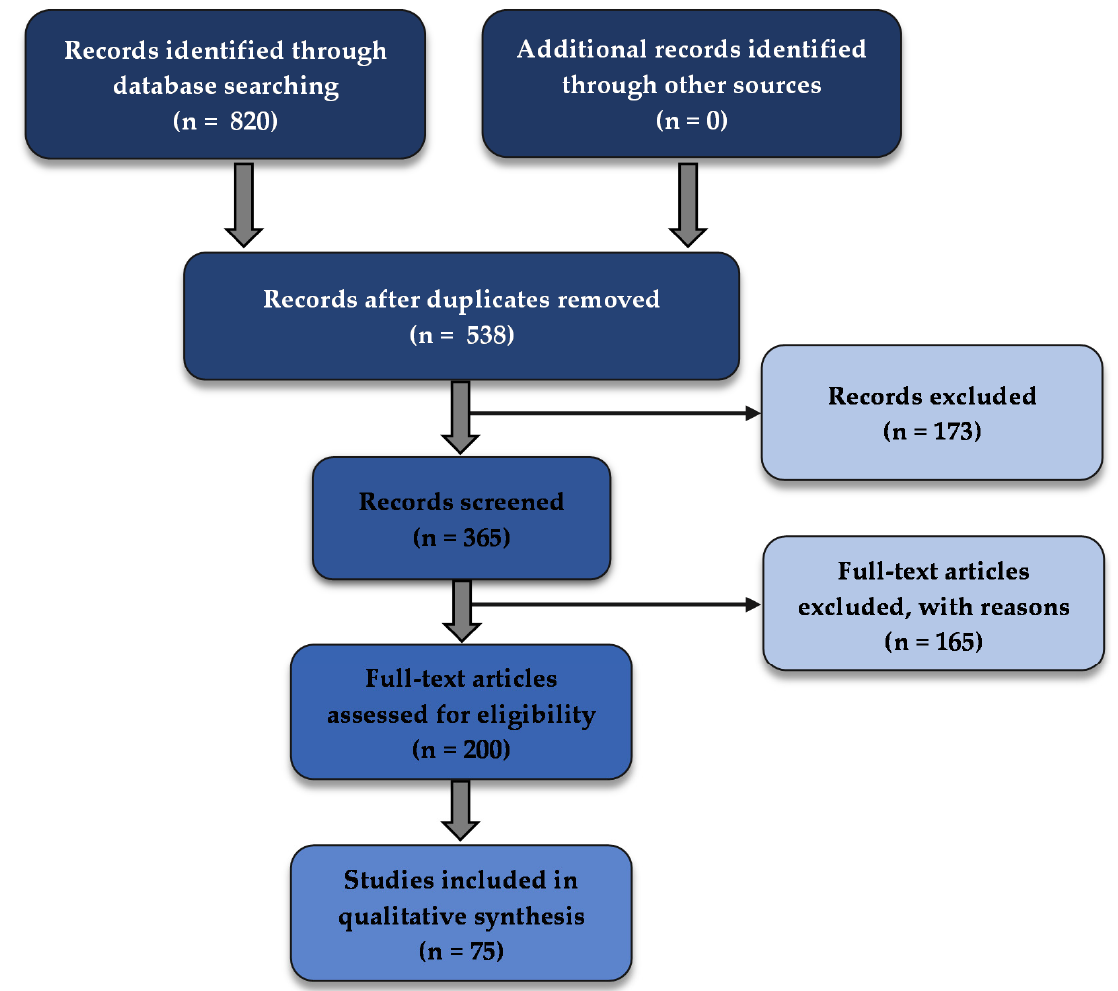
Figure 1. PRISMA flow diagram of the systematic selection of articles.